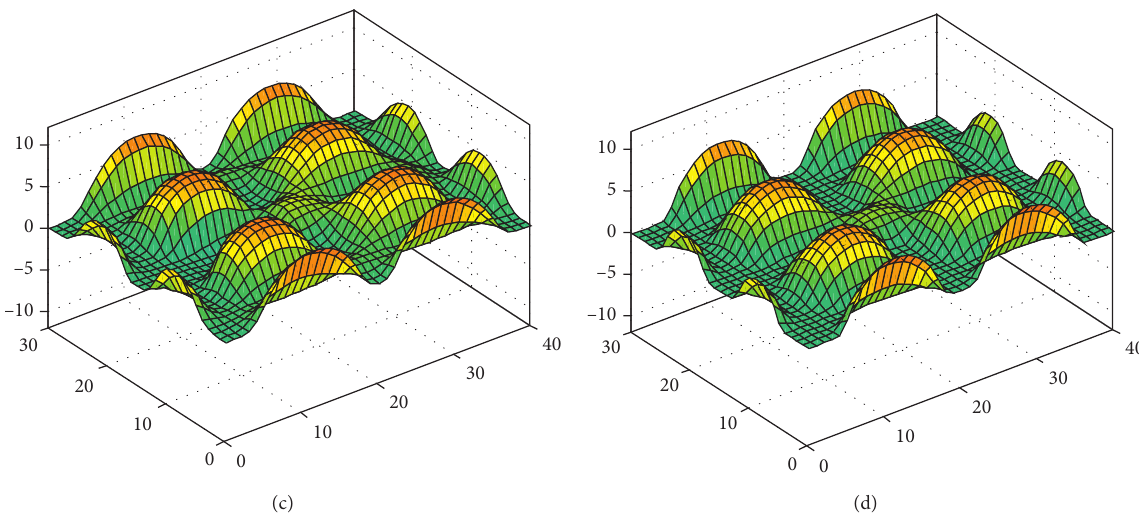
Figure 10: Evolution history of the level set surface of the damping layer for the 5th modal with one hole as the initial design. (a) Step 1. (b) Step 12. (c) Step 25. (d) Step 75.